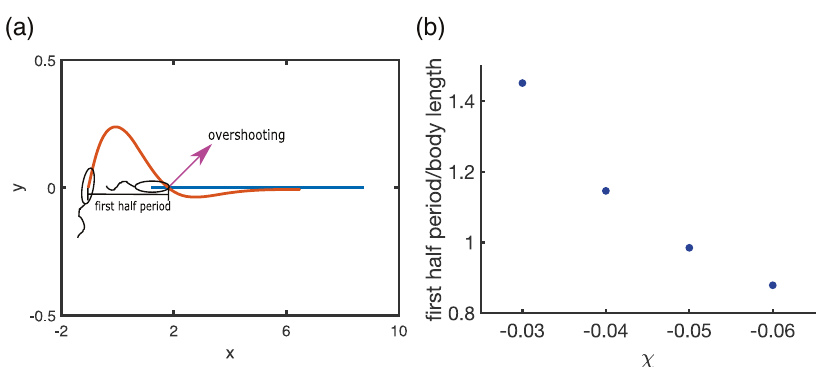
Fig. 7 Two swimmers with different initial direction. Two pushers ( β = − 2) with planar anchoring ( W = 0.5) swim one after the other with different initial direction: the leading swimmer with α ( t = 0) = 0 and the following swimmer with α ( t = 0) = π /6. It is imposed that the leading swimmer does not change its direction. The second swimmer follows the trajectory of the fi rst swimmer. a Trajectory of the center of mass of both swimmers when χ = − 0.03. b First half period (strength of oscillation) vs coupling parameter χ .